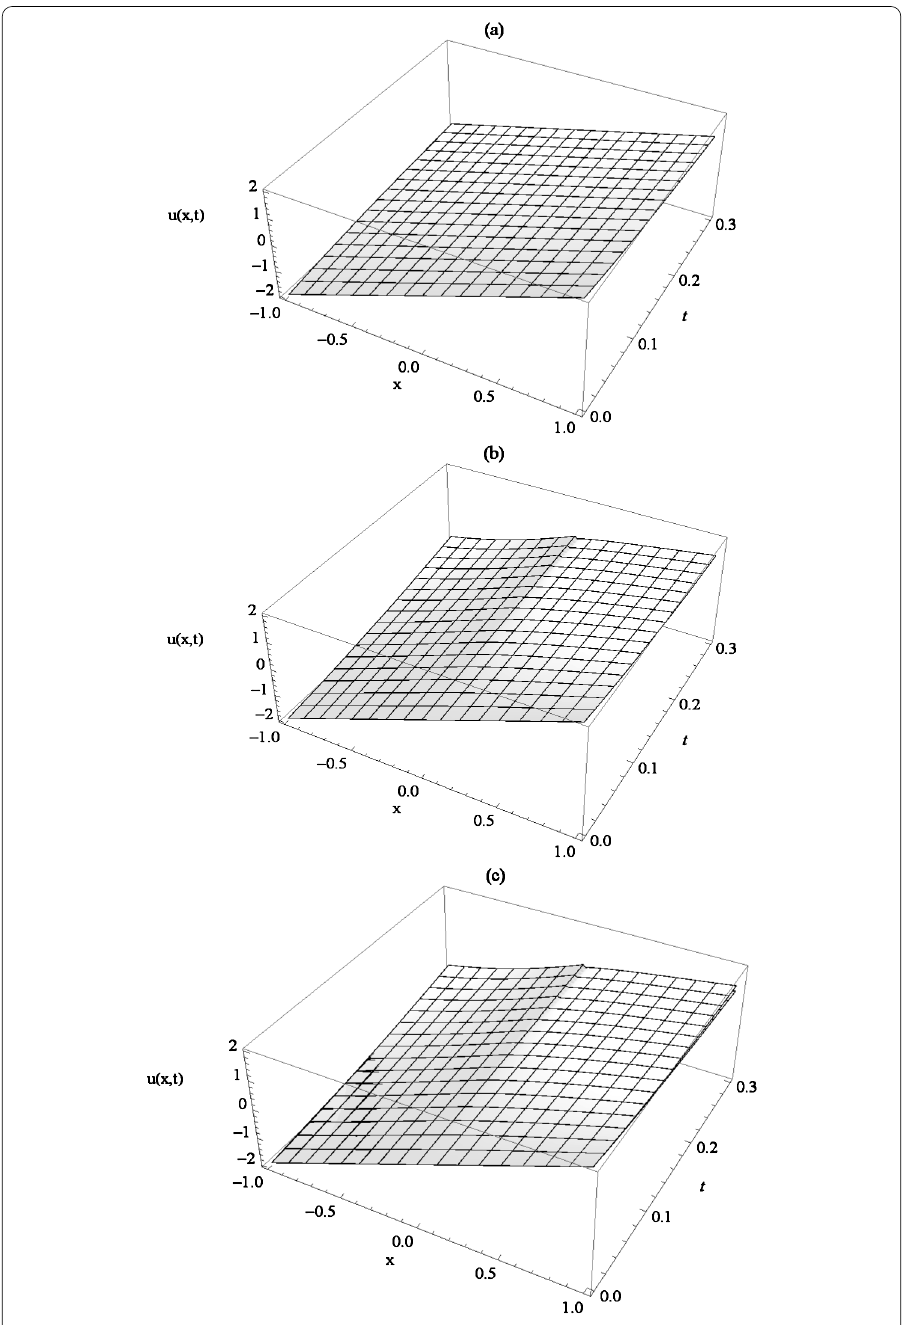
Figure 4 Combining the surface exact solution (43) and the surface approximation (34) for α = 0.7, β = 0.5, a = 1, b = 1, and c = 1. (a) The surface of the exact solution. (b) The surface of the second approximation. (c) Combining (a) - (b)